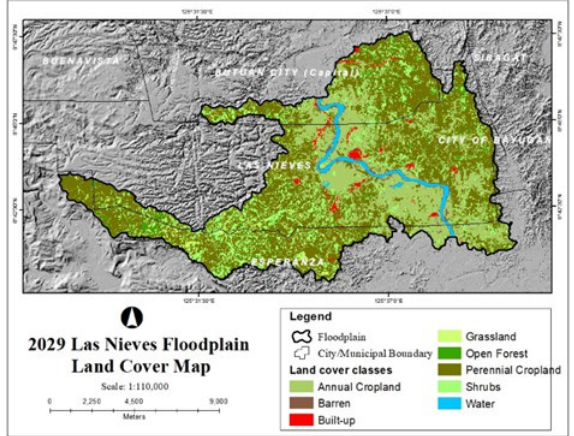
Figure 4. Predicted 2025 land cover map